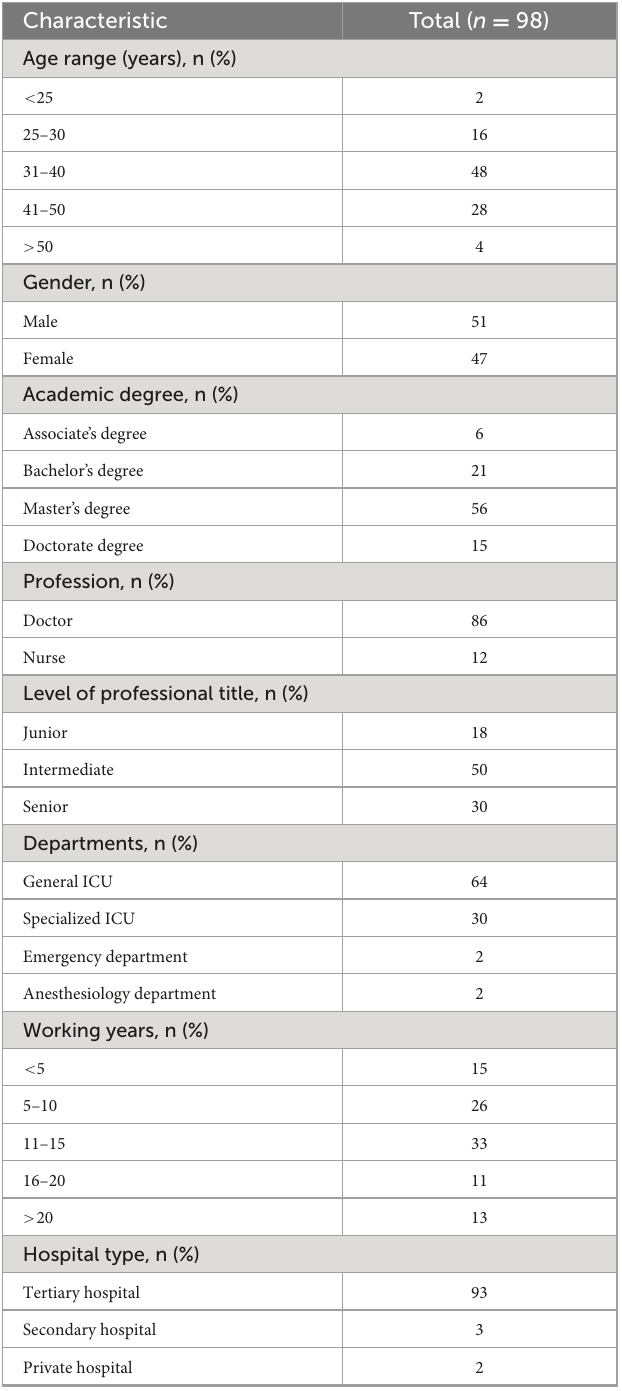
TABLE 1 The general characteristics of the survey